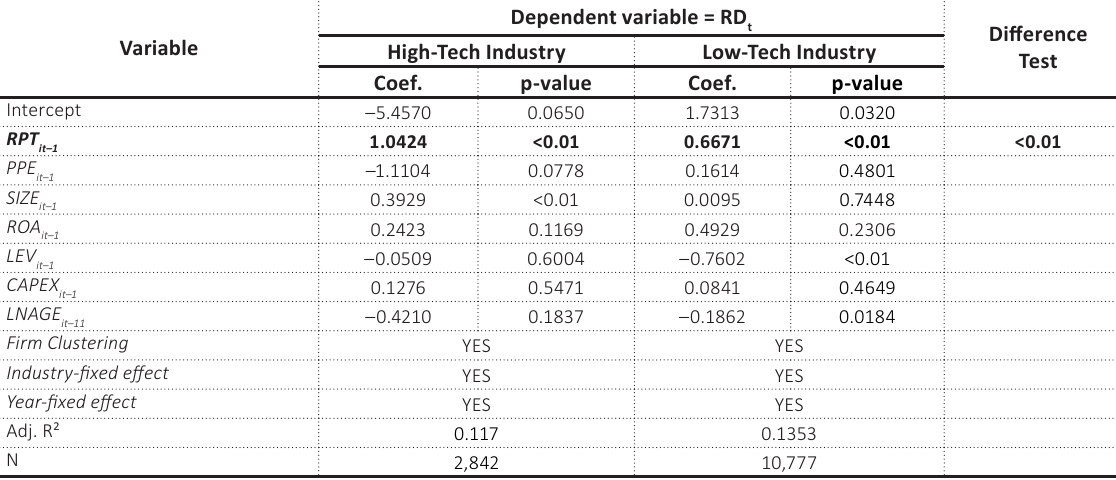
Table 6. Effect of RPTs on firm’s R&D investments based on the industry type Variable